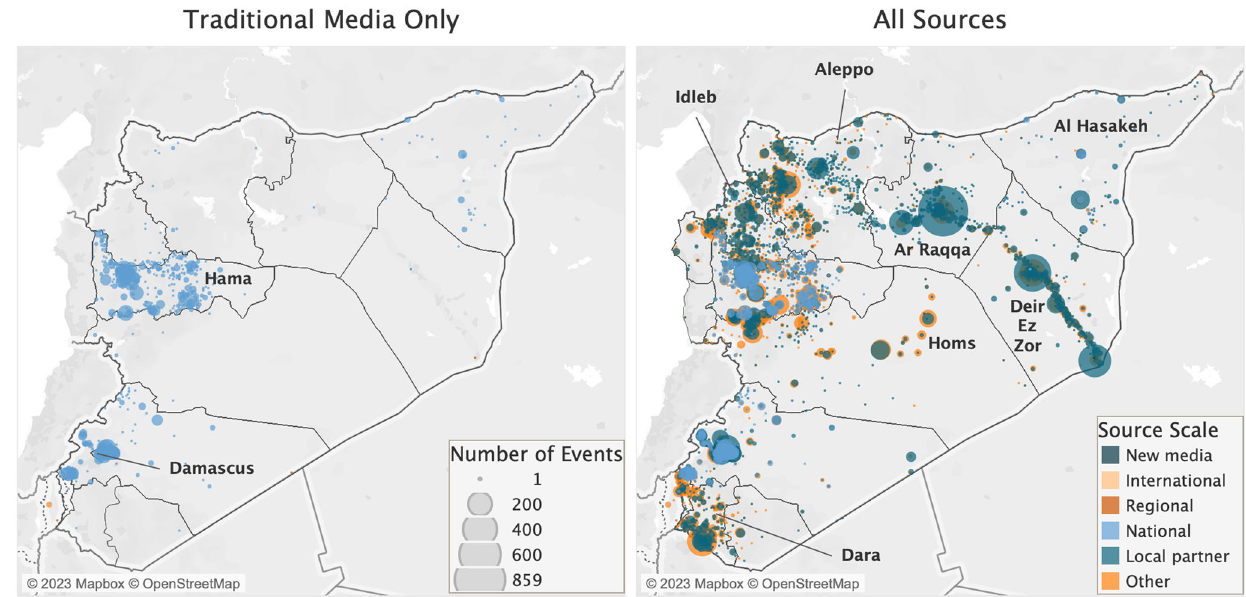
Fig. 2 2017 ACLED coverage of Syria distinguished by traditional media only vs. all source types. The categorization used on these maps relies on ACLED ’ s source-scale variable. The raw ACLED data fi le has been restructured to allow for ‘ event – source scale ’ to be the unit of analysis; all ‘ local partner ’ source types have been grouped together. ‘ Traditional media ’ here refers speci fi cally to international media (e.g. Agence France Presse), regional media (e.g. Israeli media outlets), and national media (e.g. Shaam News Network [Syrian opposition media]); all source types include the aforementioned traditional media types as well as new media (e.g. Twitter accounts of trusted sources), information from local partners (e.g. Liveuamap, the Syrian Network for Human Rights, Airwars; for more information, see ACLED ’ s ‘ Syrian Partner Network ’ ), and other non-traditional sources (e.g. the Syrian Observatory for Human Rights). ACLED coverage of Syria in 2017 by source type, depicting the differences geographically (across governorates) and by violence type. Figure created by